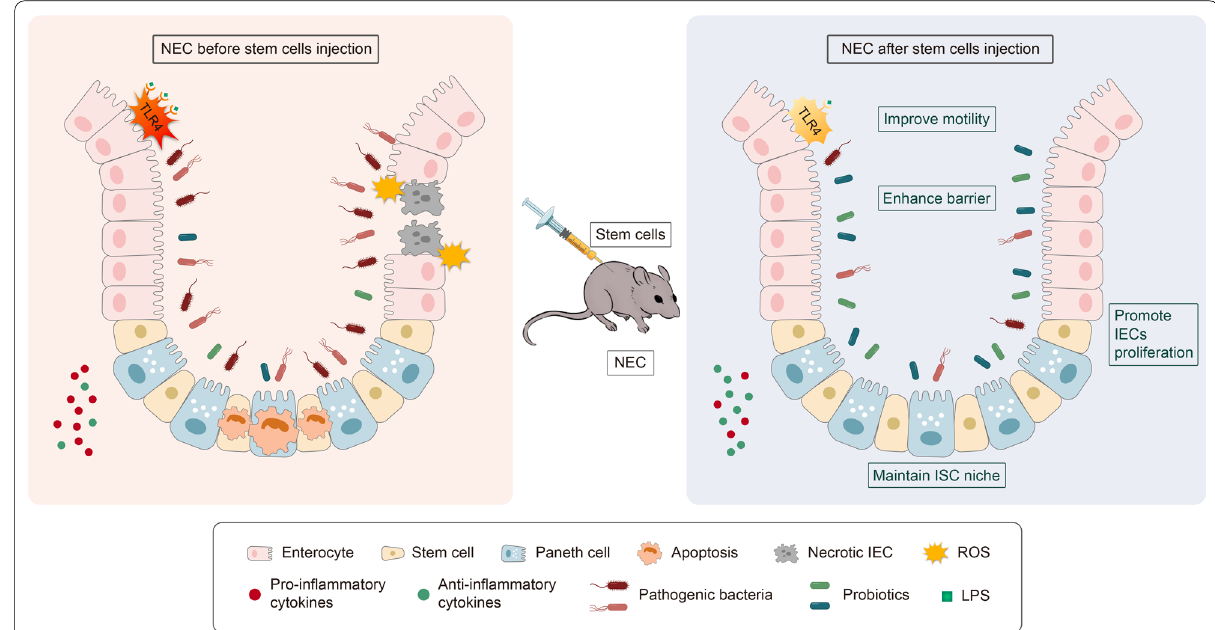
Fig. 1 Therapeutic effects of stem cells in NEC. Schematic illustrating the therapeutic effects of stem cells in the injured intestines of NEC model rats. With the injection of stem cells, the experimental NEC intestine has been shown to decrease inflammation, apoptosis, necrosis, and oxidant stress, balance bacteria, enhance barrier, inactivate TLR4, maintain ISC niche, improve motility, and promote IECs proliferation. ROS reactive oxygen species; LPS lipopolysaccharide; TLR4 toll‑like receptor